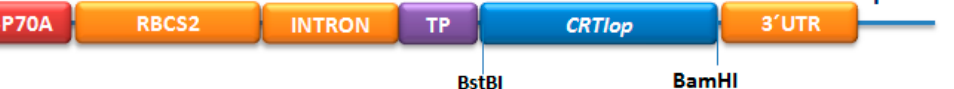
Figure 1. Expression cassette of the pSI106PLK-tp CRTIop plasmid.Abbreviations: HSP70A, heat shock protein 70A promoter; RBCS2, ribulose 1,5-biphosphate carboxylase small subunit promoter; TP, chloroplastic transit peptide; CRTIop , codon-optimized bacterial phytoene desaturase; 3 ′ UTR terRBCS2, ribulose 1,5-biphosphate carboxylase small subunit terminator region.